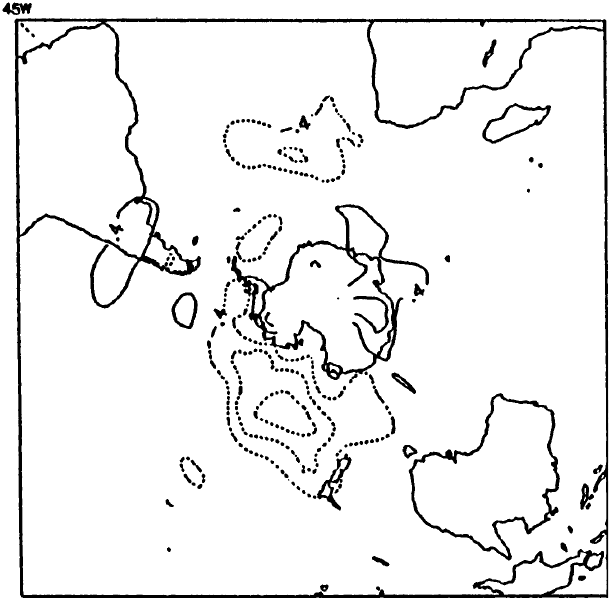
Fig. 9. Changes (NOICE minus control) in the 3–9 days filtered standard deviation of mean sea level pressure for winter. Contours every 0.4 hPa; negative contours are dashed . The zero contours are